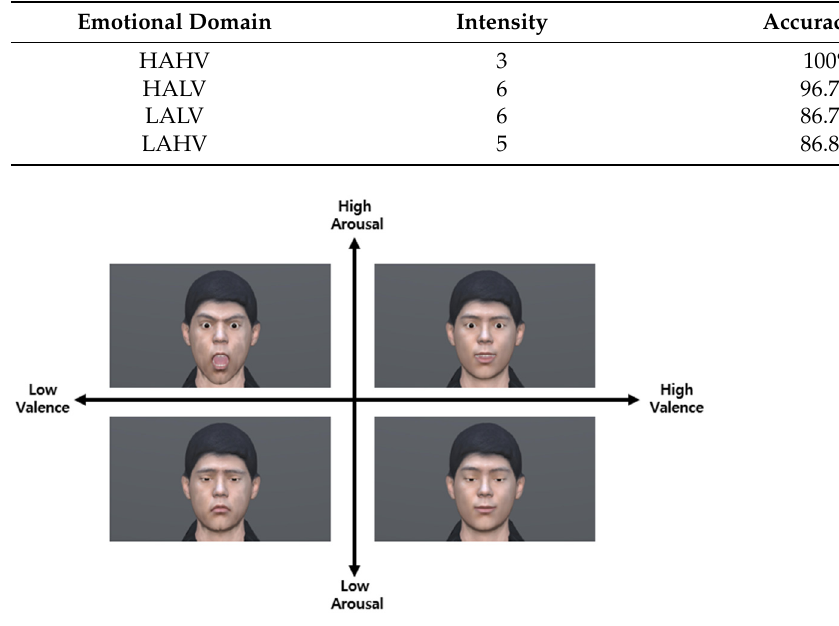
Table 5. Results of highest accuracy for each emotional domain and corresponding intensity.